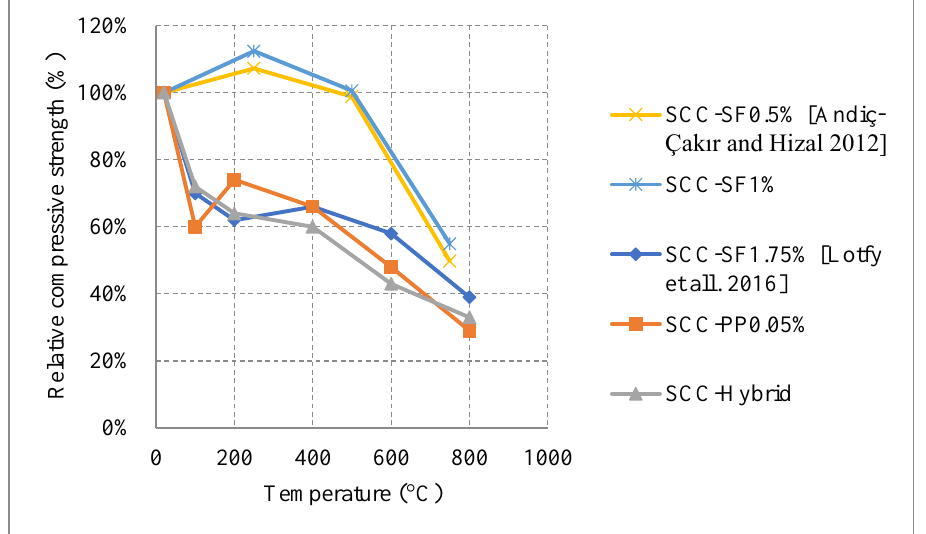
Figure 35. Relative compressive strength of naturally cooled FRSCC with different constituents. SF: Steel Fiber, PP: Polypropylene Fibers [102,107].